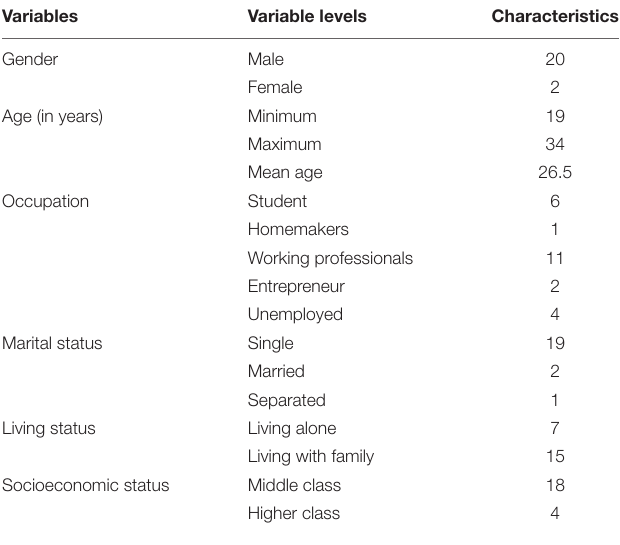
TABLE 1 | Demographic characteristics of the